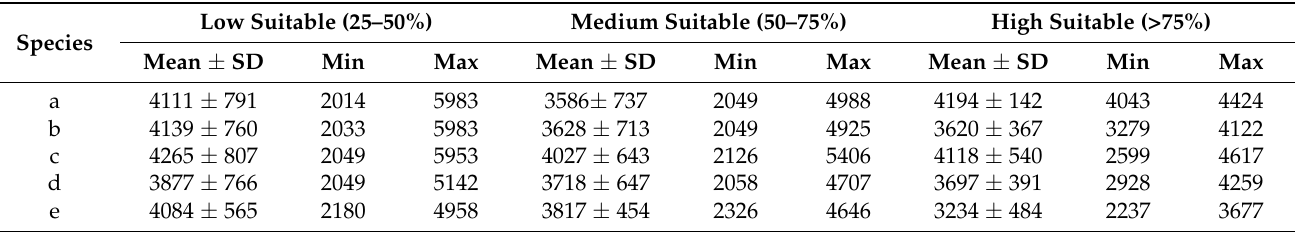
Table 5. Elevational pattern in species potential distribution in climate change scenarios under current climate conditions, in regions exhibiting high, medium, and low probability of species occurrence. All values in meters above mean sea level. (a: Meconopsis , b: M. integrifolia , c: M. horridula , d: M. racemosa , e: M. punicea